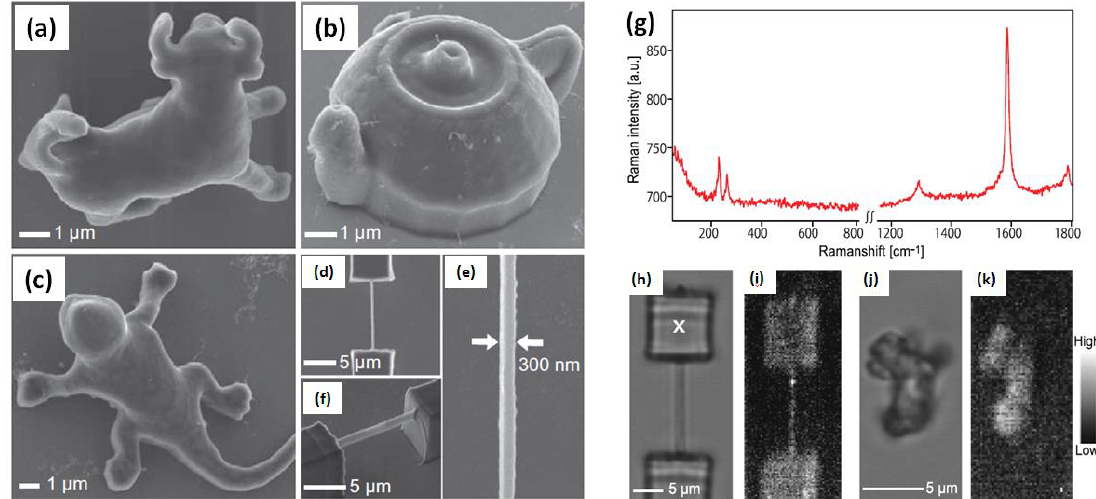
Figure 1. 3D micro/nano structural SWCNT/polymer composites are fabricated by using the TPP lithography. The structures in ( a – f ) are a 8-µm-long micro bull, a micro tea pod, a micro lizard, a nanowire suspended between two micro boxes, magnified image of ( d ), and perspective view of the nanowire, respectively; ( g ) shows a Raman spectrum taken from the box suspending the nanowire with an excitation wavelength of 785 nm. Laser power and exposure time are 2.8 mW and 60 s, respectively; ( h ) A bright field image of the 300-nm-thick nanowire suspended between two boxes; ( i ) A G-band Raman image taken at the same area in ( h ). Laser power and exposure time are 1.4 mW and 10 s, respectively; ( j ) A bright field image of a 8-µm-long micro bull; ( k ) A G-band Raman image taken at the same area in ( h ). Laser power and exposure time are 2.8 mW and 10 s, respectively. Copyright © 2013, with permission from Elsevier [73].